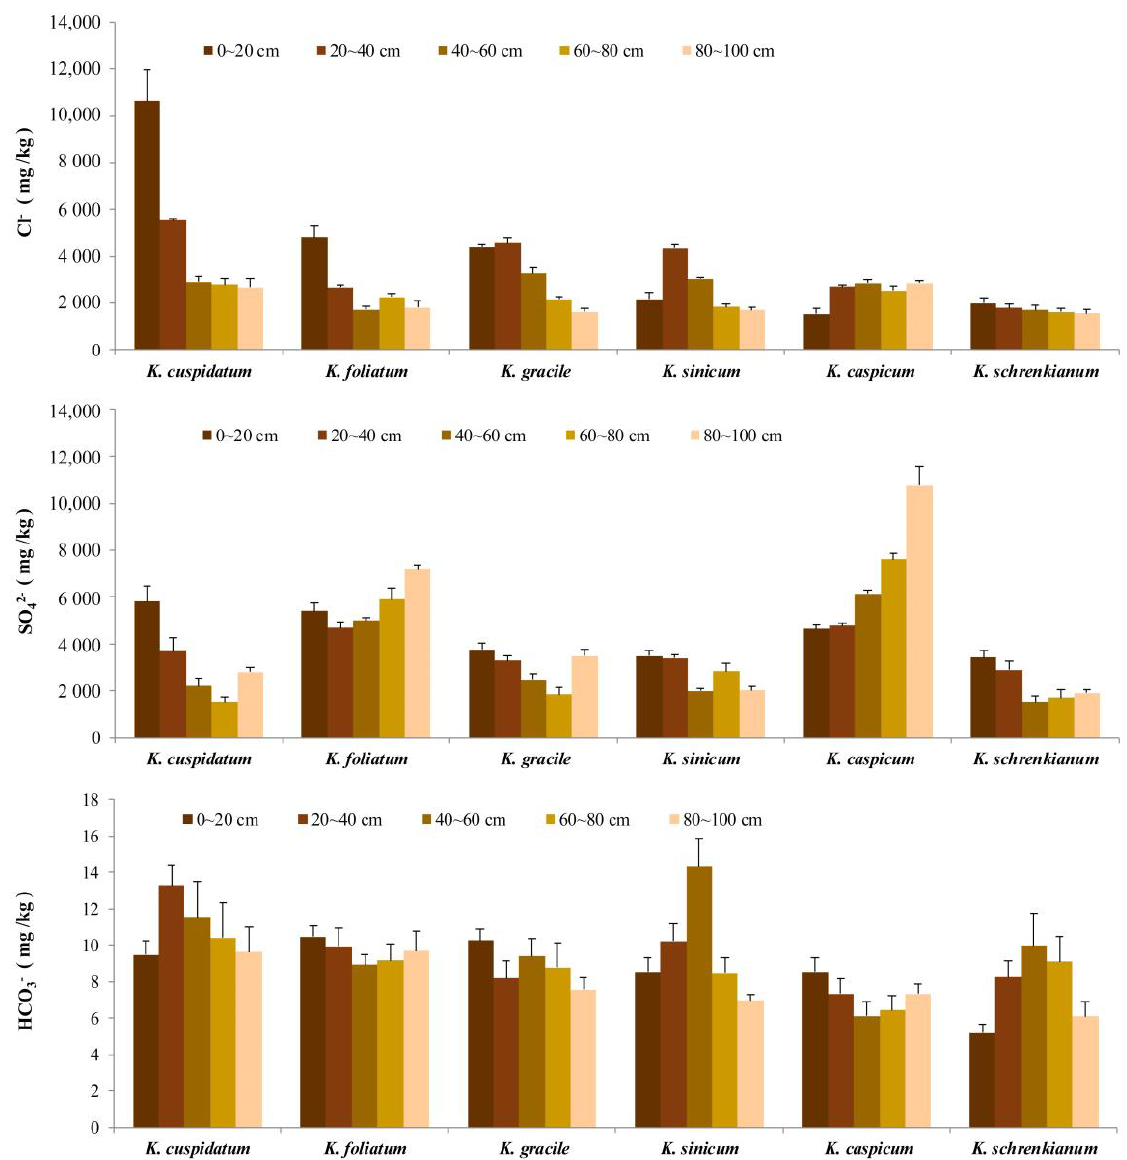
Figure 5. Concentrations of Cl − , SO 42 − , and HCO 3 − in soil from indicated depths in areas occupied by the six Kalidium species. The values shown are means with SE ( n = 3).